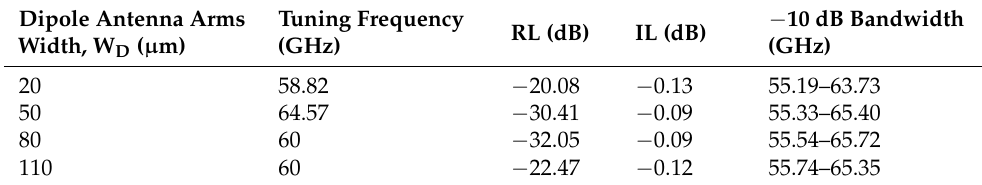
Figure 6. V-band back-to-back MS-to-WG transition.